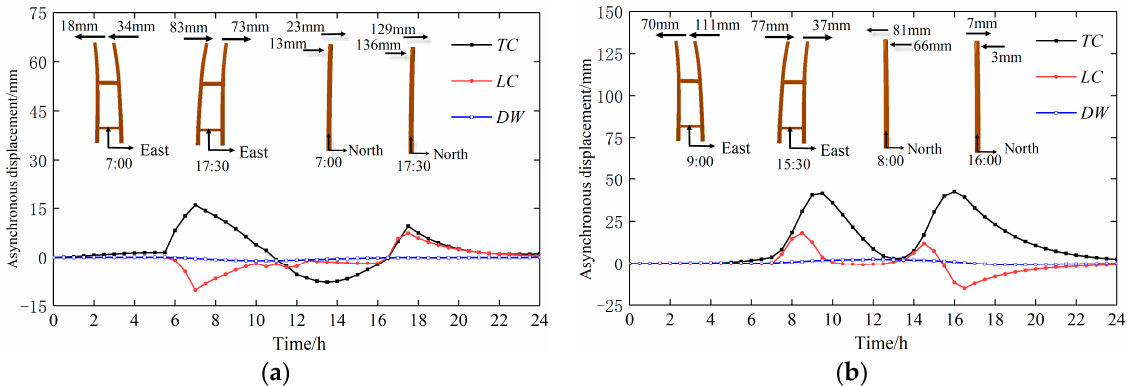
Figure 20. Asynchronous displacement of bridge pylon deformation: ( a ) Asynchronous displace- ment in spring (autumn). ( b ) Asynchronous displacement in summer. According to the above in spring (autumn). ( b ) Asynchronous displacement in analysis, after considering the in fl uence of shadow on the deformation of steel bridge py- lon, the unsynchronized deformation can be accurately re fl ected.